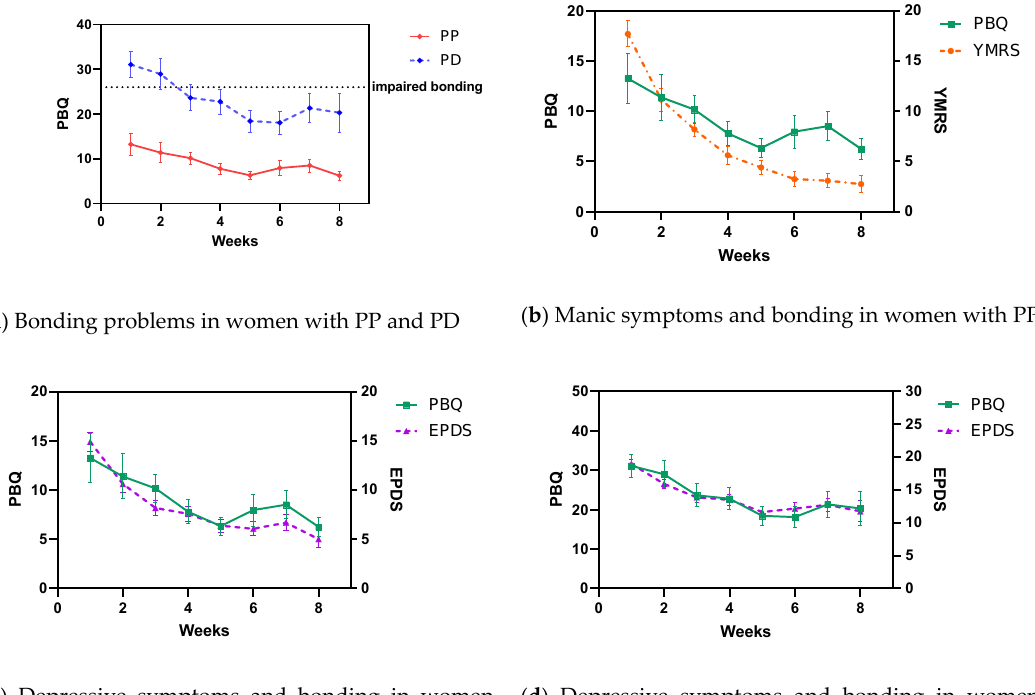
Figure 2. Change in mean mother-to-infant bonding scores and depressive (EPDS) and manic (YMRS) symptoms in women with postpartum psychosis and postpartum depression (including standard error bars). Abbreviations: PP = postpartum psychosis; PD = postpartum depression; PBQ: Postpartum Bonding Questionnaire; YMRS = Young Mania Rating Scale; EPDS = Edinburgh Postnatal Depression Scale.